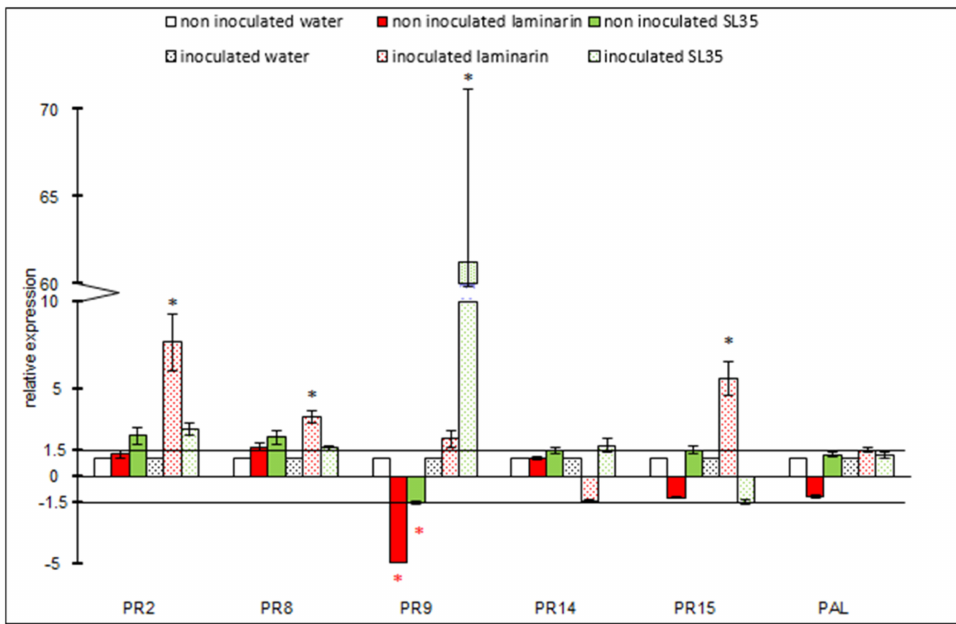
Figure 3. Relative expression levels of some genes encoding PR proteins and PAL in tomato leaves subjected to SL35 or laminarin treatment by foliar spraying (days 1, 3 and 5). Plants were infiltrated with B. cinerea conidia at day 8 (dotted histograms). All samples were harvested at day 9. Gene expressions were calculated relative to the appropriate water controls (non-inoculated water for non-inoculated laminarin and non-inoculated SL35, inoculated water for inoculated laminarin and inoculated SL35). Values are means of at least 5 independent samples ± SE. One-way ANOVA was performed to evaluate statistical differences. Only relative expression values out of the interval (+1.5, − 1.5), were taken in consideration. * Means significant statistical differences in comparison with controls ( p <